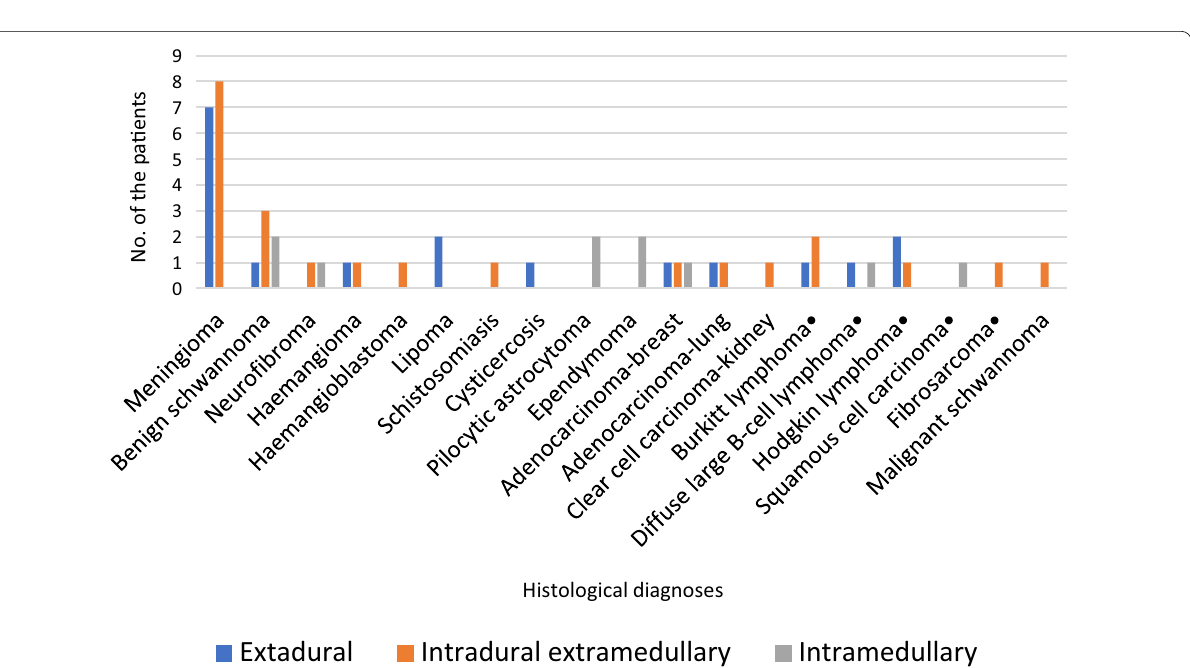
Fig. 1 Distribution of the histological diagnoses according to the anatomical areas of the spinal cord ( N